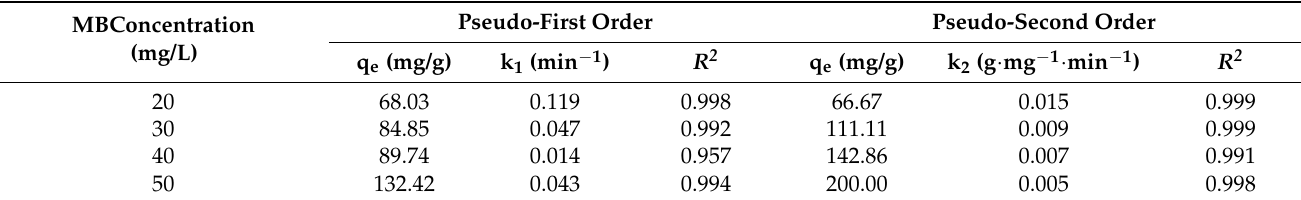
Table 1. Parameters of kinetic models for MB photocatalysison 1.4% CuO/bentonite (400 ◦ C) composite. MBConcentration